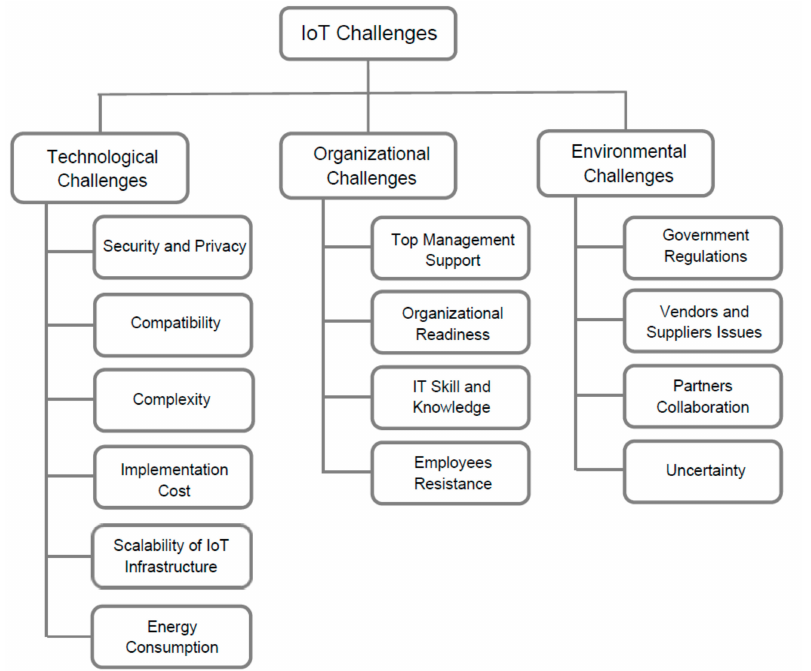
Figure 8. IoT adoption challenges for